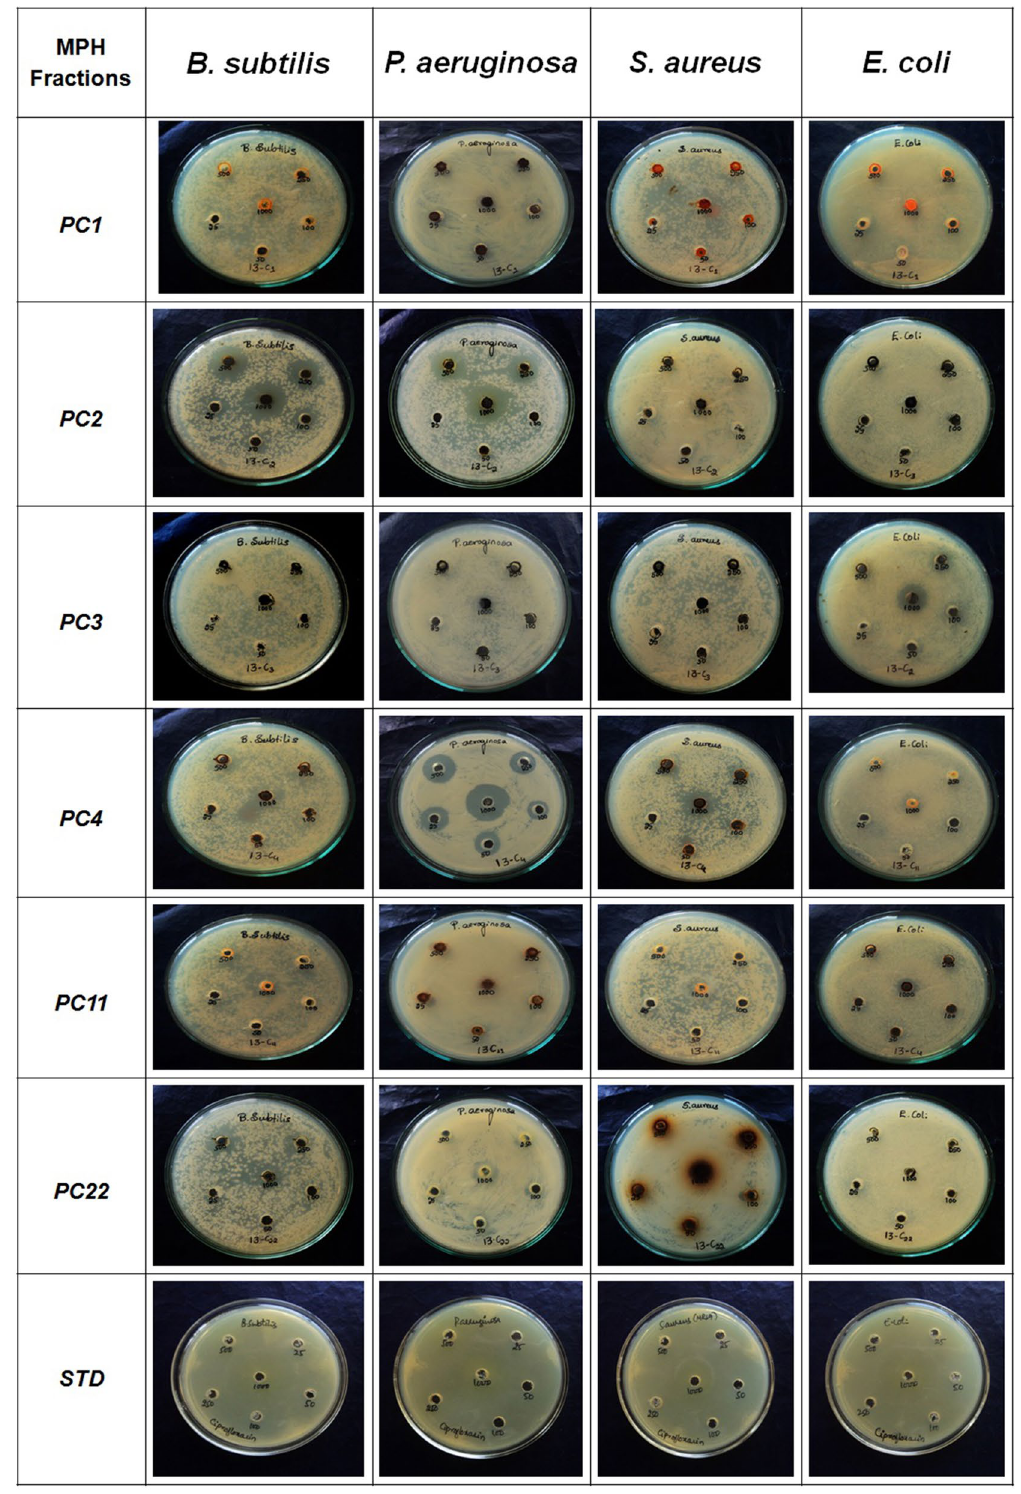
Figure 3. Antibacterial activity of hexane fractions of M. paniculata leaves against B. subtilis, P.aeruginosa, S. aureus and E. coli. PC1, PC2, PC3, PC4, PC11, PC22 represents different collected fractions and the drug ciprofloxacin were used as